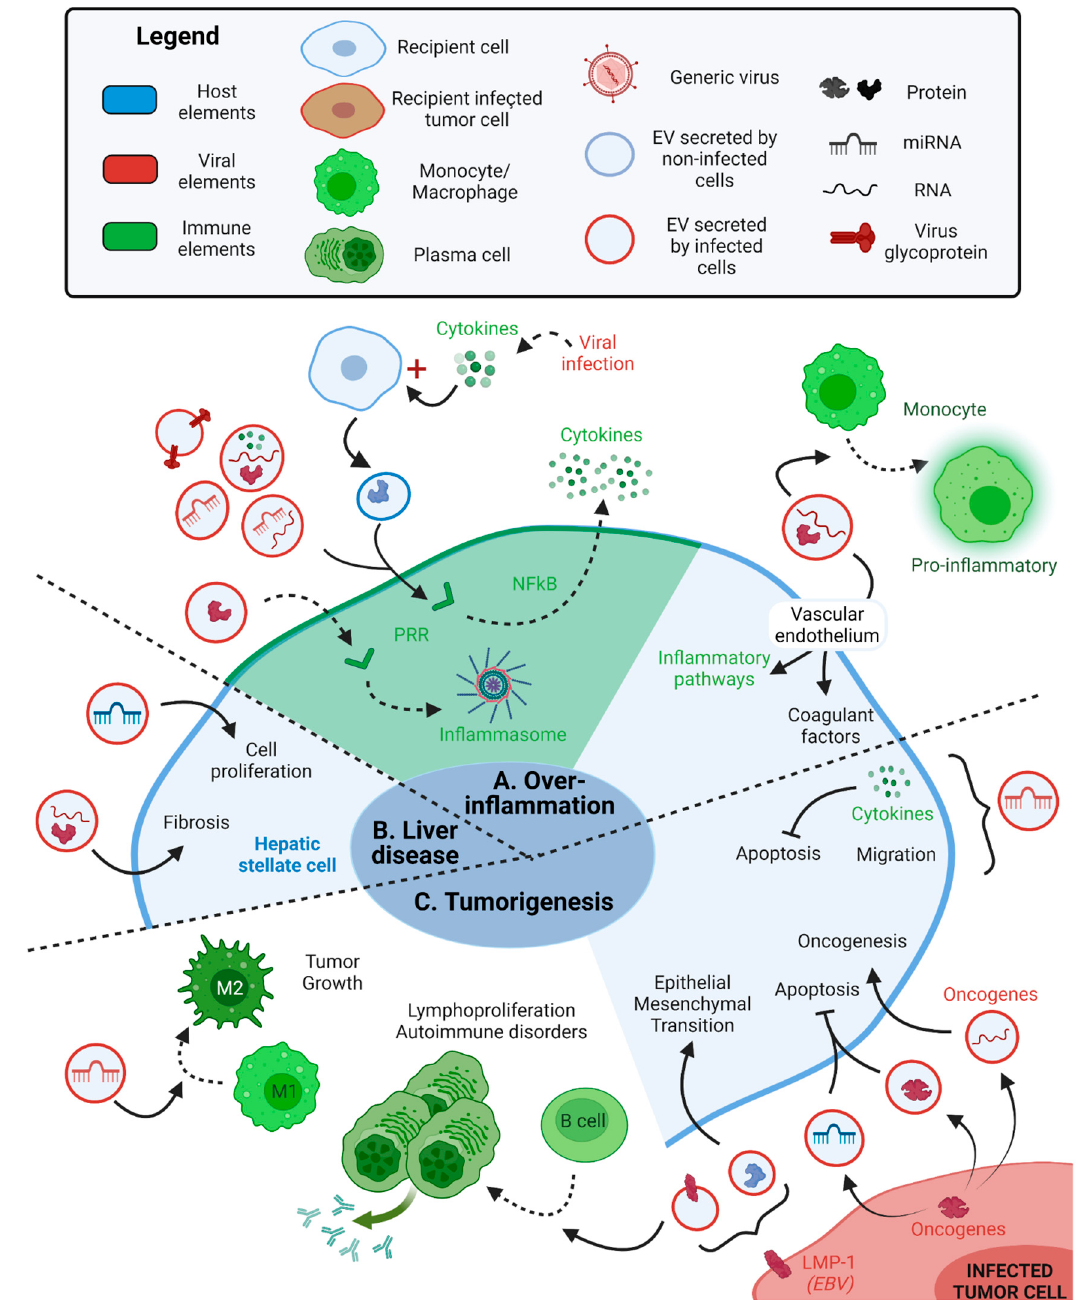
Figure 4. EVs mediate virus-associated disorders. ( A ) EVs secreted by both infected and non-infected cells lead to over-inflammation. Virus-EVs containing viral proteins can indirectly activate the inflamma- some in immune cells, supporting over-inflammation [HIV [106]. Virus-EVs containing viral proteins, glycoproteins, miRNAs and or mRNAs can also activate the secretion of pro-inflammatory cytokines through PRR recognition in immune cells, leading to chronic inflammation [HIV-1 [72,102,103], EBV [61], Ebola virus [93], HTLV-1 [105]. Virus infection induces the release of pro-inflammatory cy- tokines in the environment, which activate the secretion of EVs by non-infected cells. These EVs con- tain host proteins that activates the secretion of pro-inflammatory cytokines by recipient immune cells through PRR recognition [DV [107]. Virus-EVs containing viral proteins and mRNAs induce the phe- notype switch of recipient monocytes into a pro-inflammatory phenotype and promote inflammatory and coagulant pathways in recipient endothelial cells [Zika virus [57]. ( B ) EVs secreted by infected cells are associated with liver disease. Virus-EVs containing viral proteins and RNA or host miRNA are integrated by hepatic stellate cells and either stimulate cell proliferation or fibrosis in the liver [HBV [108], HCV [109]. ( C ) EVs secreted by infected tumor cells enhance tumorigenesis. Infected tumor cells